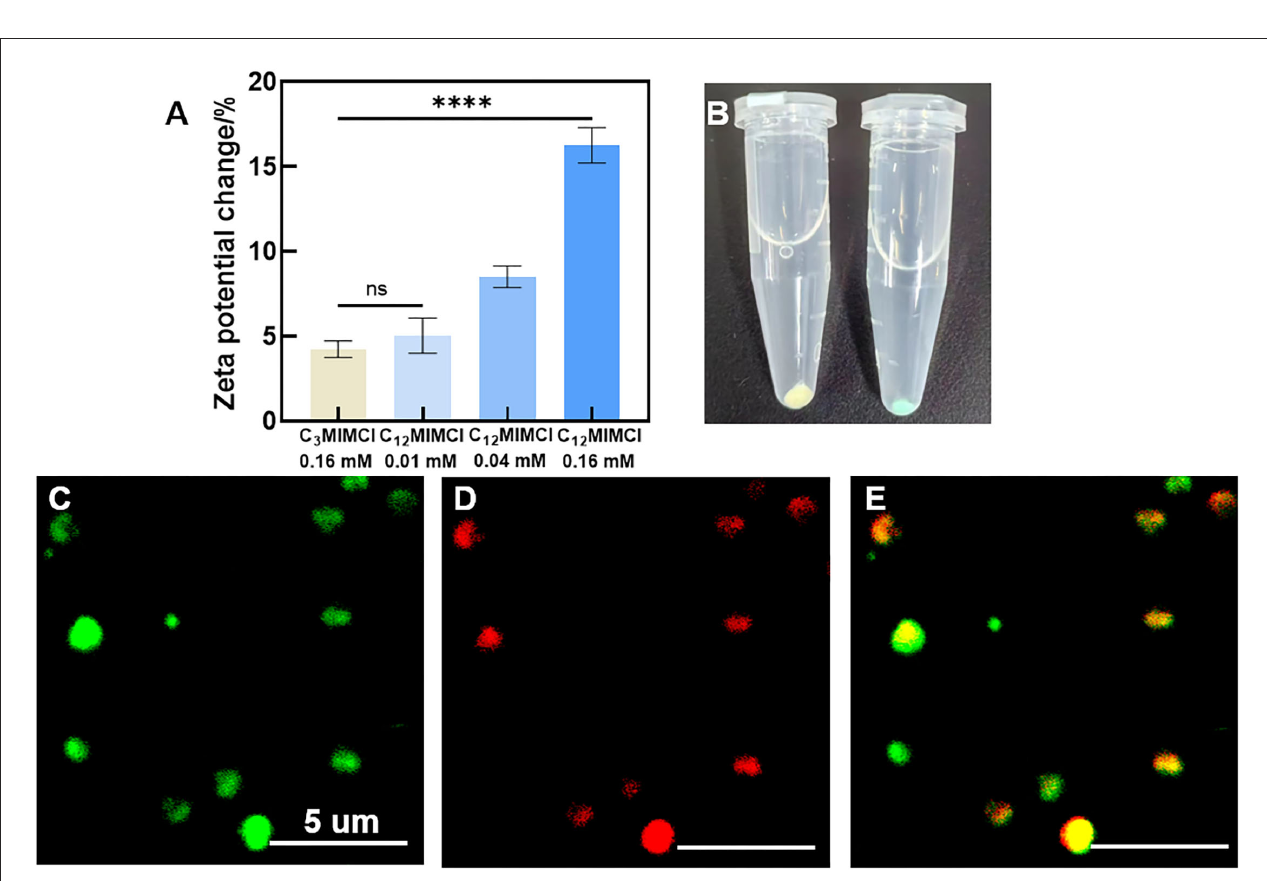
FIGURE5 The changes of Staphylococcus aureus surface. (A) Zeta potentials of Staphylococcus aureus co-cultured with C 3 MIMCl or C 12 MIMCl in PBS for 3h. (B) Picture of Staphylococcus aureus incubated with Cy5, SE-C 12 MIMCl. (C–E) CLSM images of C 12 MIMCl interacting with Staphylococcus aureus . Green: Staphylococcus aureus transfected with GFP (C) , Red: Cy5, SE-C 12 MIMCl (D) , merged (E) . Data in (A) represent the mean ± s.d. Statistical significance of (A) was calculated via two-tailed unpaired Student’s t -test. Ns means no significant difference, ****P < 0.0001.